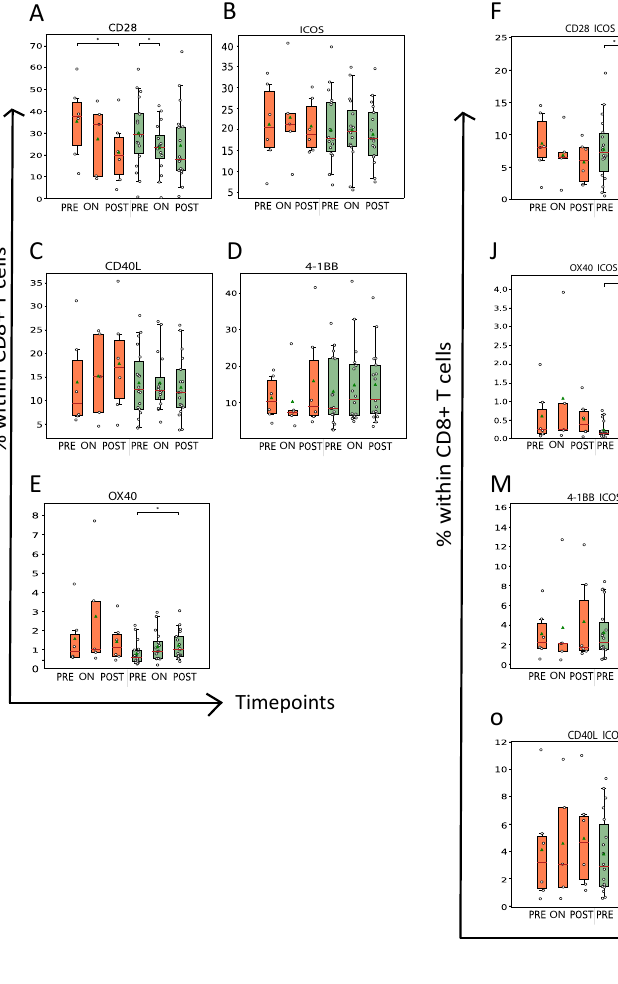
Figure 4. Plasma EBV DNA clearers demonstrate late increase in frequency of OX40-expressing CD8+ T cells during RT. Boxplots displaying frequency of CD8+ T cells expressing ( A – E ) a single type and ( F – O ) two different types of co-stimulatory receptors. Details regarding display of patient groups, time points and statistical analyses are described in legend to Figure 2. * p <